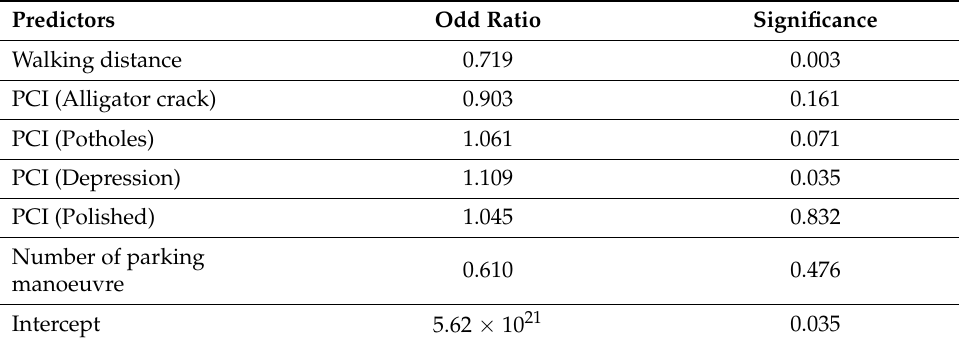
Table 3. Resulted values of the parking decision coe ffi cient.